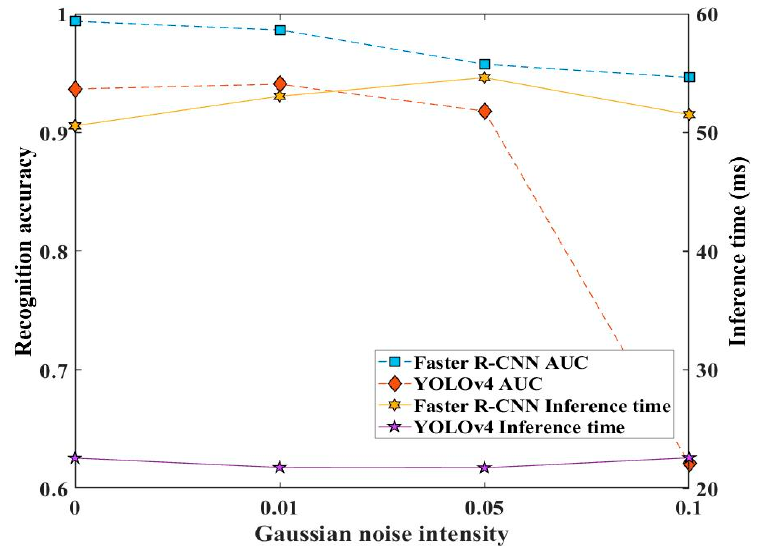
Figure 14. Effect of noise intensity of developing datasets on the recognition accuracy and inference time of the two approach models.